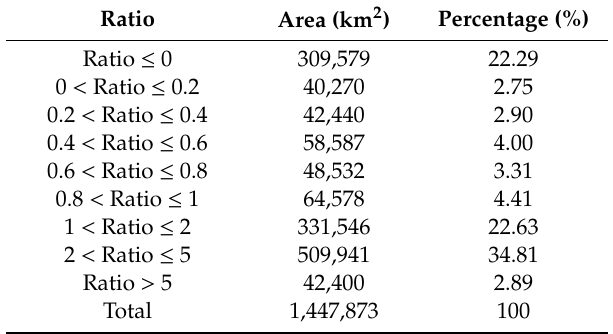
Figure 5. Contribution of net atmospheric water input to water storage decline across the SWUS from 2003 to 2014. Table 2. Contribution of net atmospheric water input to water storage change (ratio = (decreasing rate of net atmospheric water input) / (decreasing rate of water thickness)).